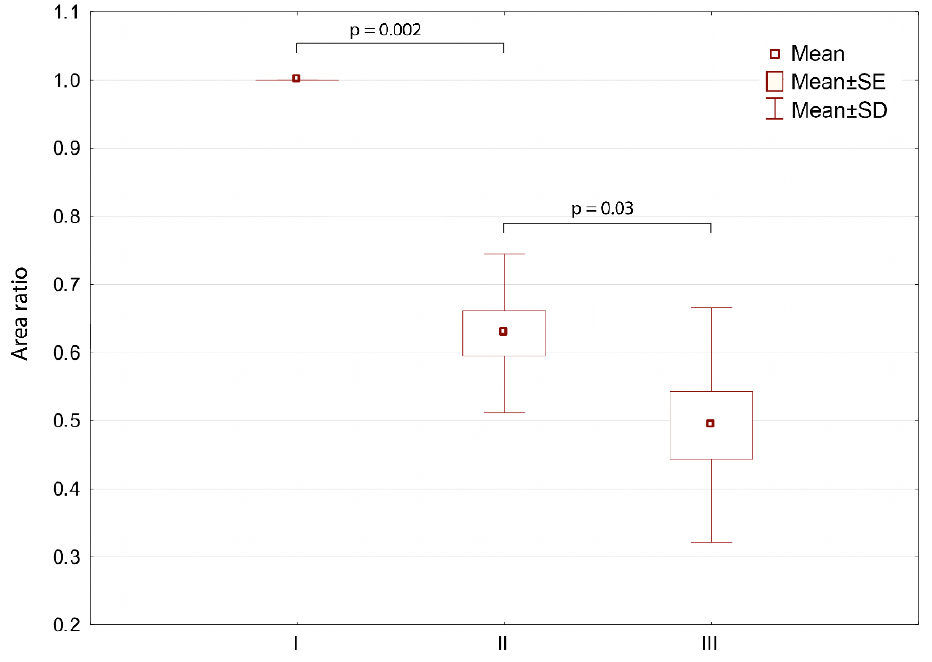
Figure 4. Isotherm area changes obtained during therapy as an average for all studied patients treated with THBOT, taken into account as a ratio of pixel numbers from the 2nd and 3rd periods to that in the 1st